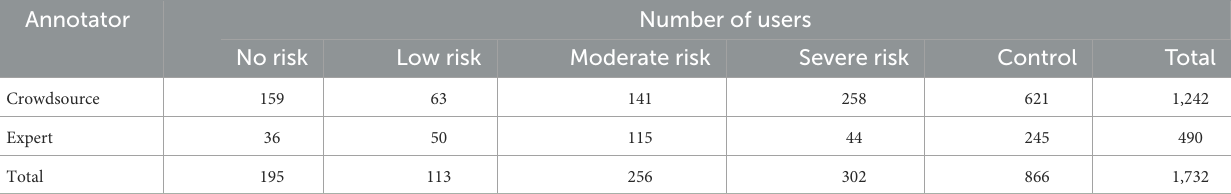
TABLE 1 UMD reddit suicidality dataset.